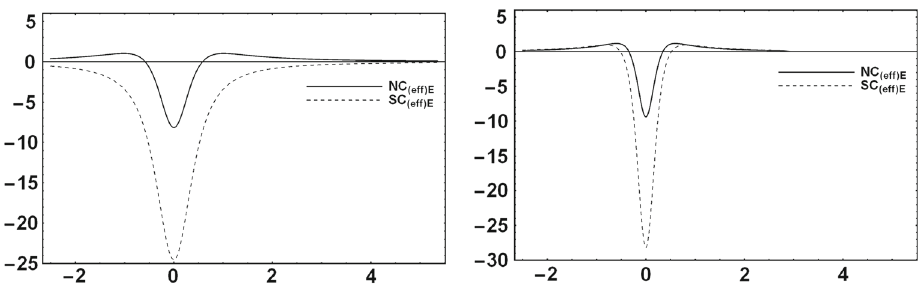
Fig. 7 The behavior of scale factor, Hubble parameter, acceleration of the Universe and effective energy density in matter bounce scenario. Right panel: The behavior of effective pressure, effective EoS and mat-